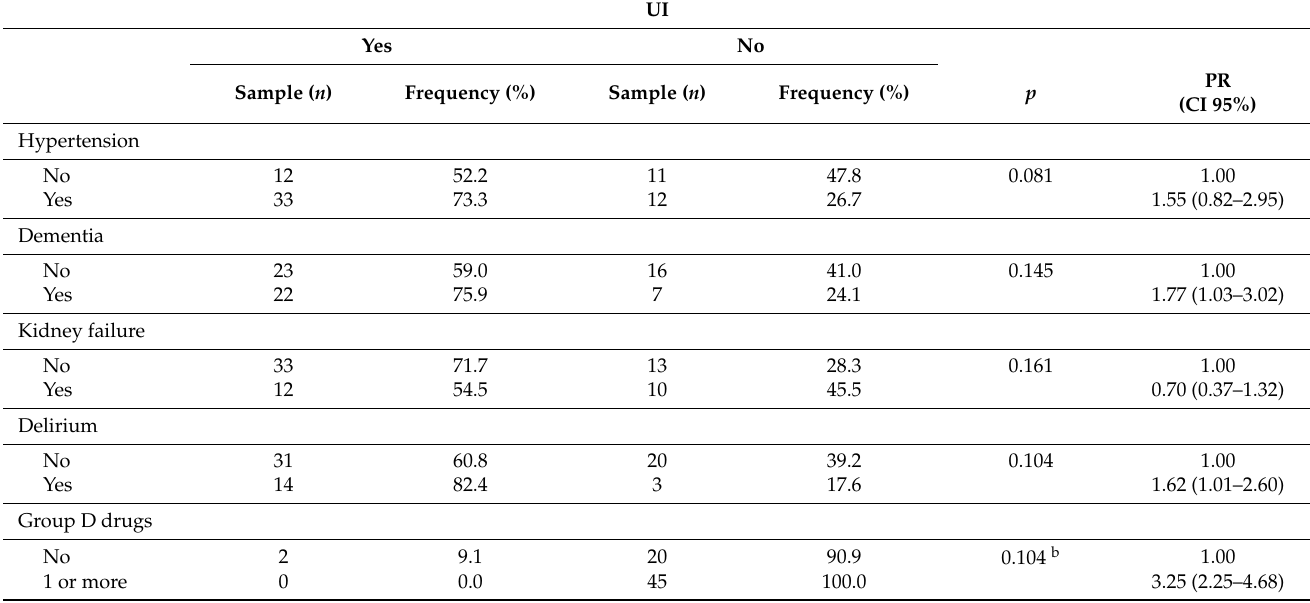
Table 5. Association between UI (according to the MDS) and categorical independent variables with p value under 0.20 among 68 residents living in five nursing homes (NHs) from Osona, Spain (2020). UI